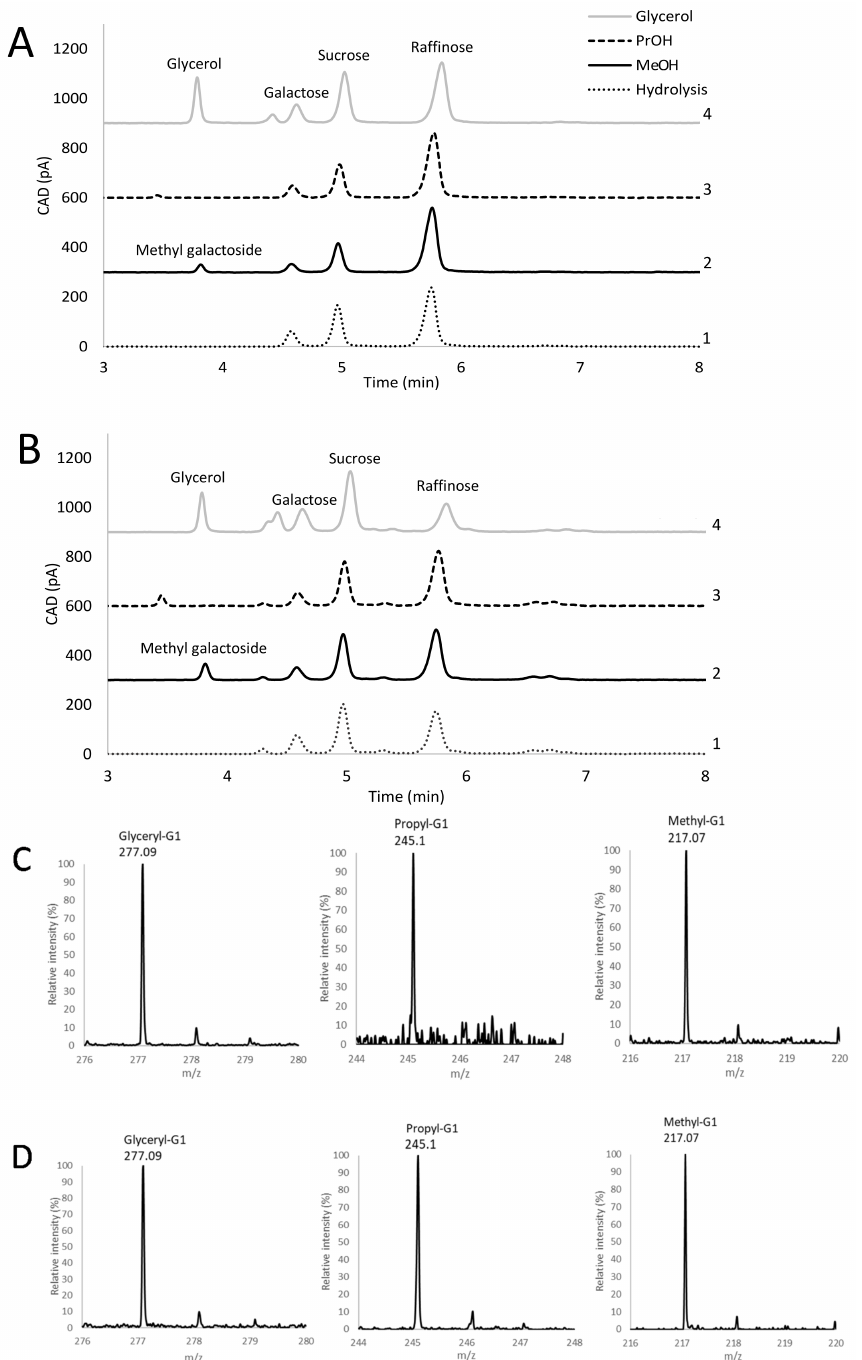
Figure 4. Chromatograms for evaluation of transglycosylation capacity with raffinose as donor substrate. Panel ( A , B ) show chromatograms of 0.4 M raffinose incubated with 12 nkat/mL of BoGal36A ( A ) and Aga27A ( B ) in the presence of various acceptors. (1): incubation with raffinose, without additional acceptor, (2): 10% MeOH, (3): 5% PrOH, (4): 10% glycerol. Incubations with methanol, propanol or glycerol had additional peaks in the chromatograms at 3.8, 3.4 and 4.4 min, respectively, not present in the hydrolysis control. Controls with BoGal36A or Aga27A had no peaks, and a control sample with raffinose had a single peak with an elution time of 5.8 min (data not shown). Panel ( C ) (BoGal36A) and ( D ) (Aga27A) show the mass spectra for the entire incubations where, from left to right, glycerol, propanol and methanol respectively were used as acceptors. The spectra shows a relevant m / z range for each transglycosylation